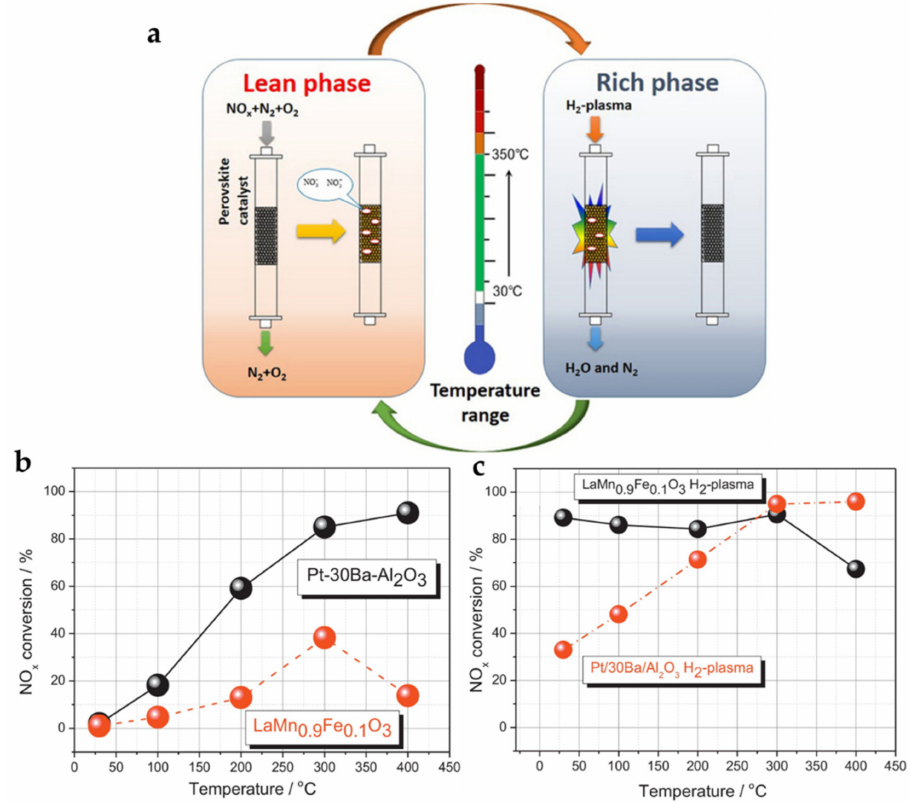
Figure 5. ( a ) Illustrative profile of NSR reaction with the assistance of H 2 -plasma; NO x conver- sion during lean/rich cycling at different temperatures over LaMn 0.9 Fe 0.1 O 3 and Pt/BaO/Al 2 O 3 : ( b ) without H 2 -plasma, ( c ) with H 2 -plasma. Reprinted with permission from [69]. Copyright 2013,